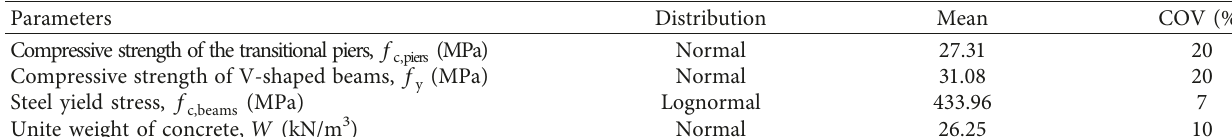
Table 2: Parameter of variable statistics.